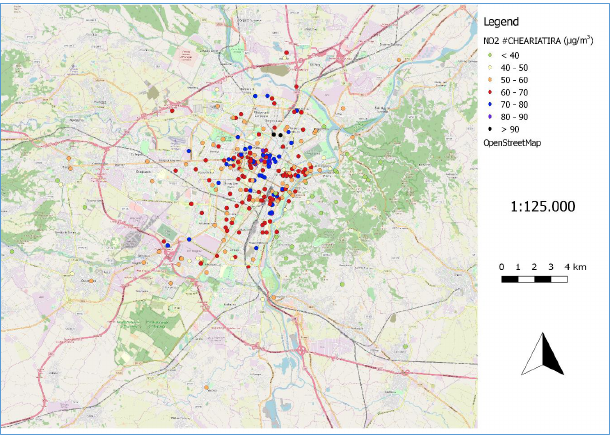
Figure 5. Map of NO 2 concentrations referred to #CHEARIATIRA samples for the campaign period (elaboration by means of QGIS 2.18).